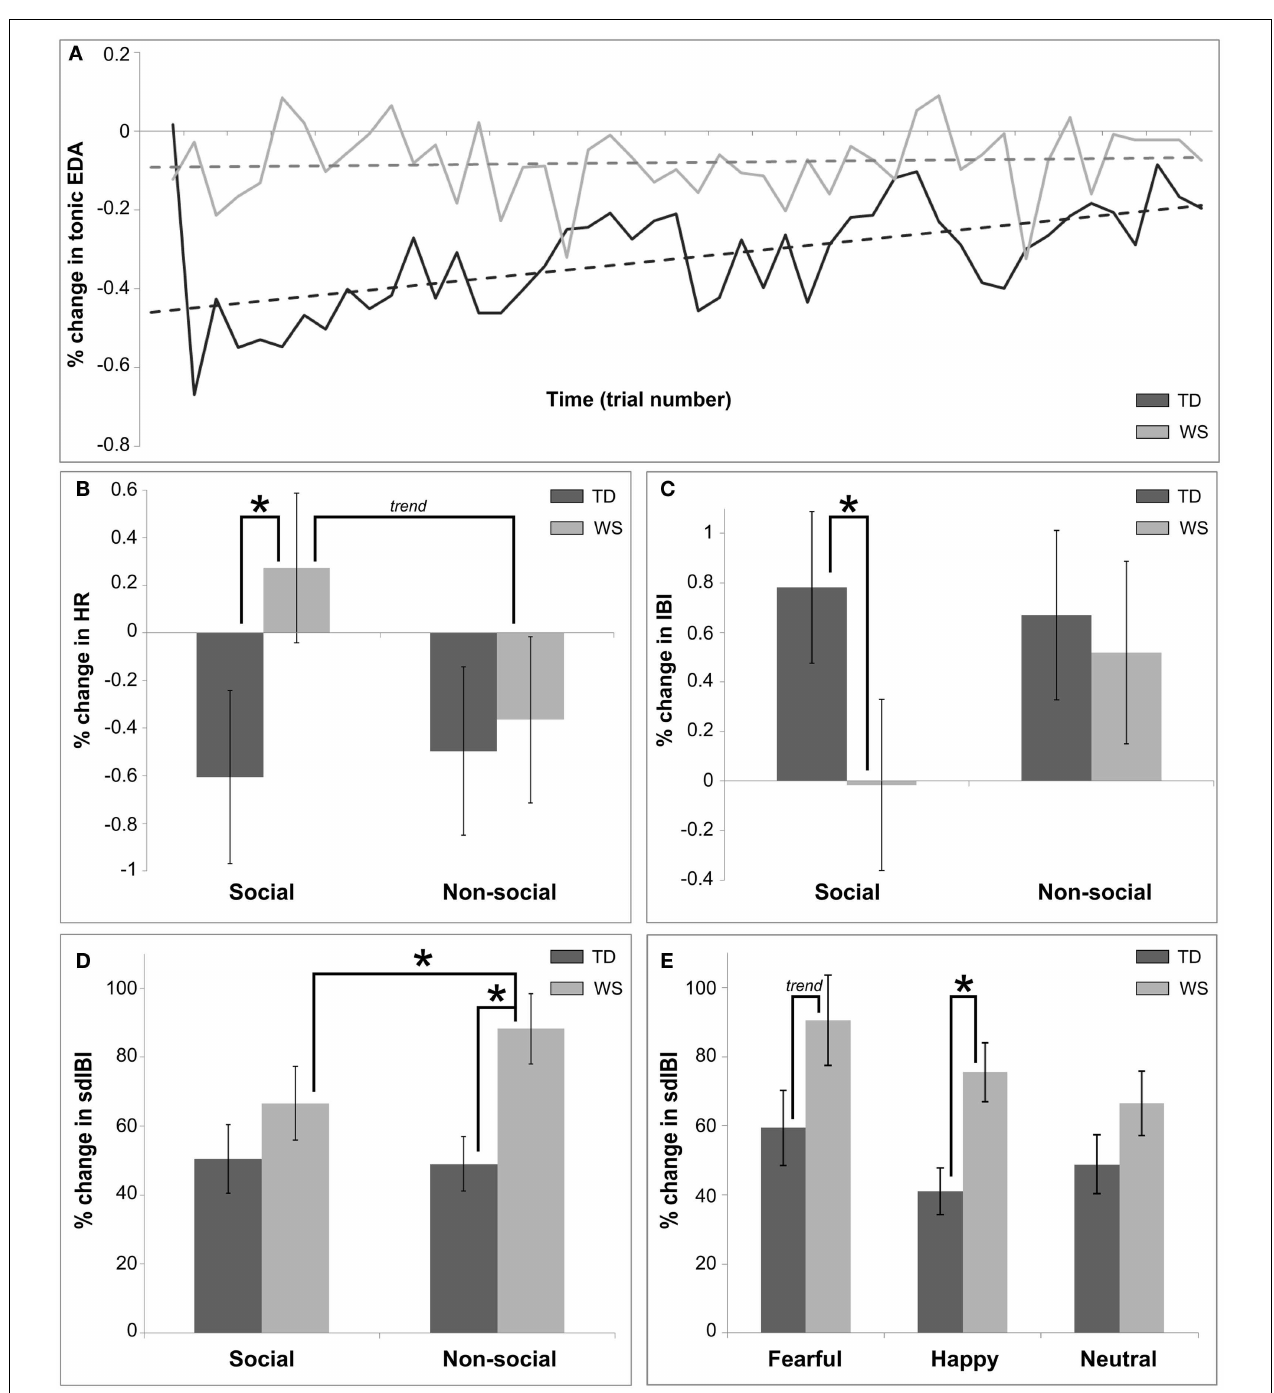
differences between social and non-social conditions inTD andWS participants, calculated as a percentage change between baseline and post stimulus in the mean IBI. (D) Displays differences between social and non-social conditions inTD andWS participants, calculated as a percentage change between baseline and post stimulus in the sdIBI. (E) Displays differences between affective stimuli inTD andWS participants, calculated as a percentage change between baseline and post stimulus in the